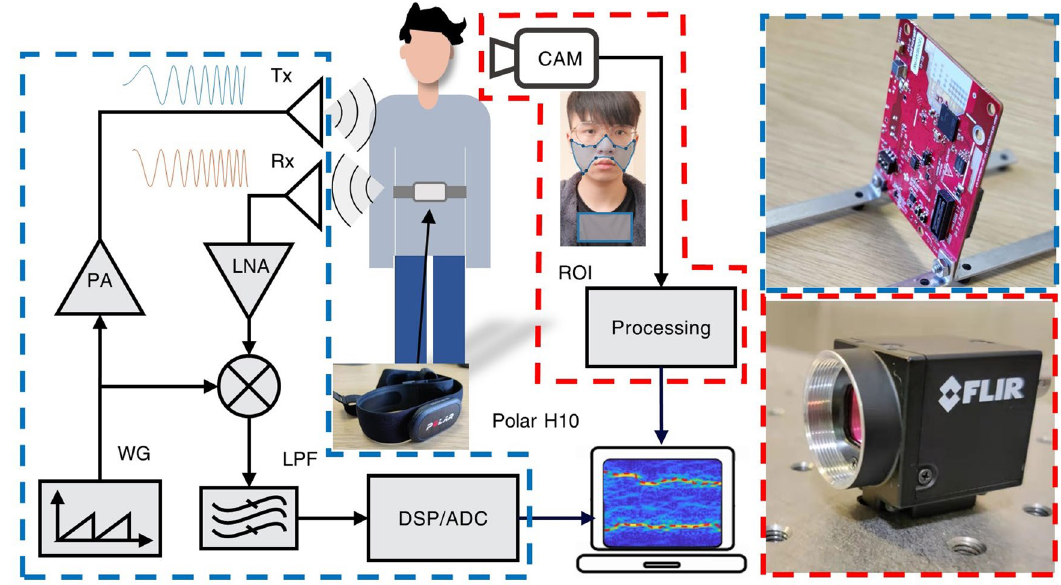
Figure 1. The schematic diagram of the system. WG: waveform generator; PA: pre-amplifier; LNA: low-noise amplifier; LPF: low-pass filter; DSP: digital signal processing unit; ADC: analogue–digital-converter; TX/RX: transmitting/receiving antennas. The blue and red enclosing is the photo of the FMCW radar and the camera used in the experiment, respectively.